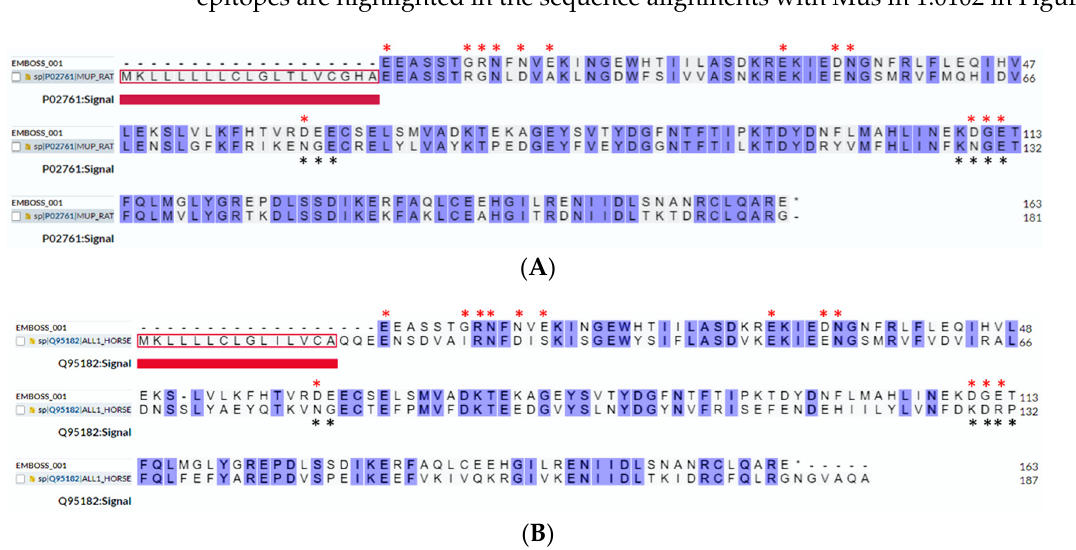
Figure 2. Sequence alignment of rMus m 1.0102 with cross-reactive allergens (blue coloured by identity on the UniProt platform). Recombinant Mus m 1.0102 is aligned with ( A ) Rat n 1, and ( B ) Equ c 1 allergens. Asterisks indicate residues involved in B-cell epitopes of rMus m 1.0102 (red) and Rat n 1 or Equ c 1 allergens (black), as predicted by the Discotope 2.0 server. Proteins are represented by their accession numbers in the UniProtKB database, while the query protein Mus m 1.0102 is indicated as EMBOSS_001 (dashed line at the beginning of the sequence indicates omission of the secretion signal). Residues in the red box are secretion signals (thick red lines).